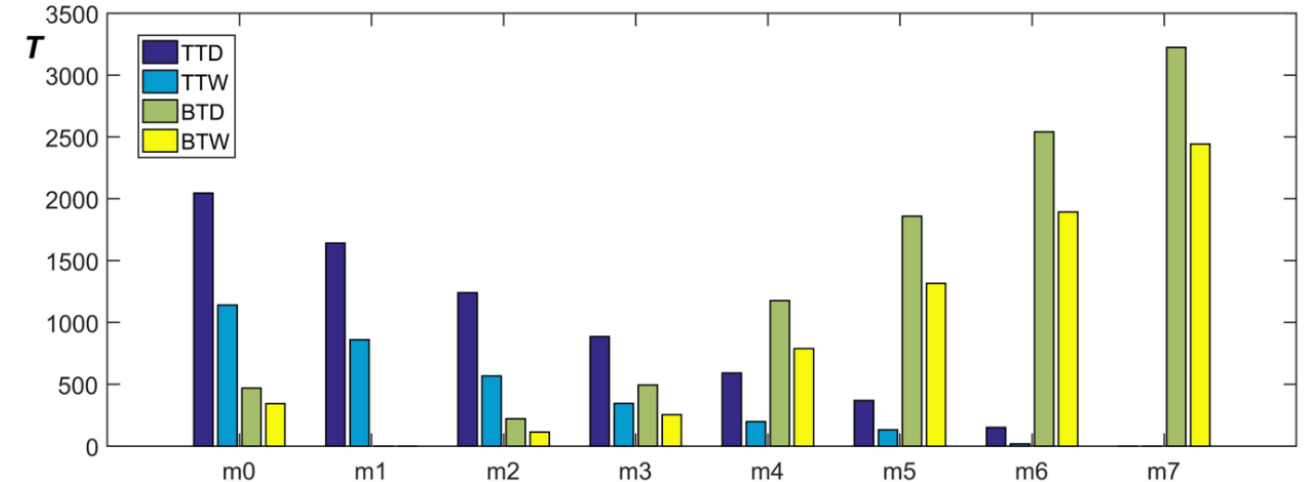
Figure 14. Steady TTD, TTW, BTD, and BTW results.